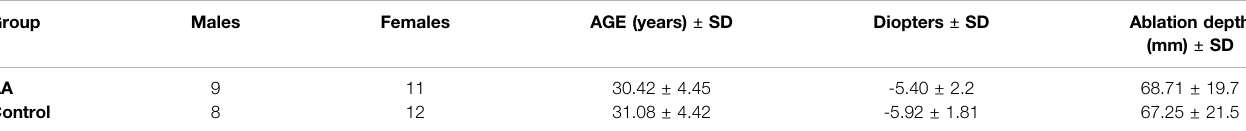
TABLE 2 | Characteristics of enrolled patients.